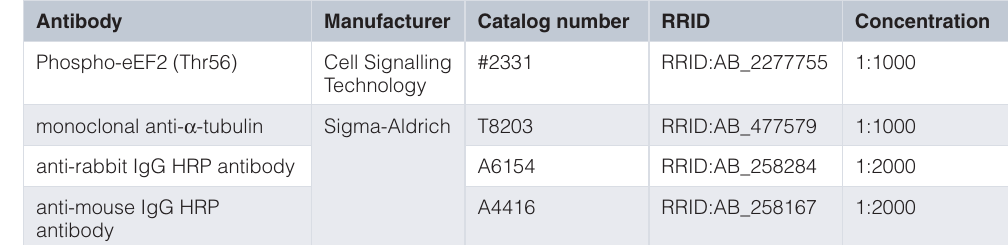
Table 2. Primary and secondary